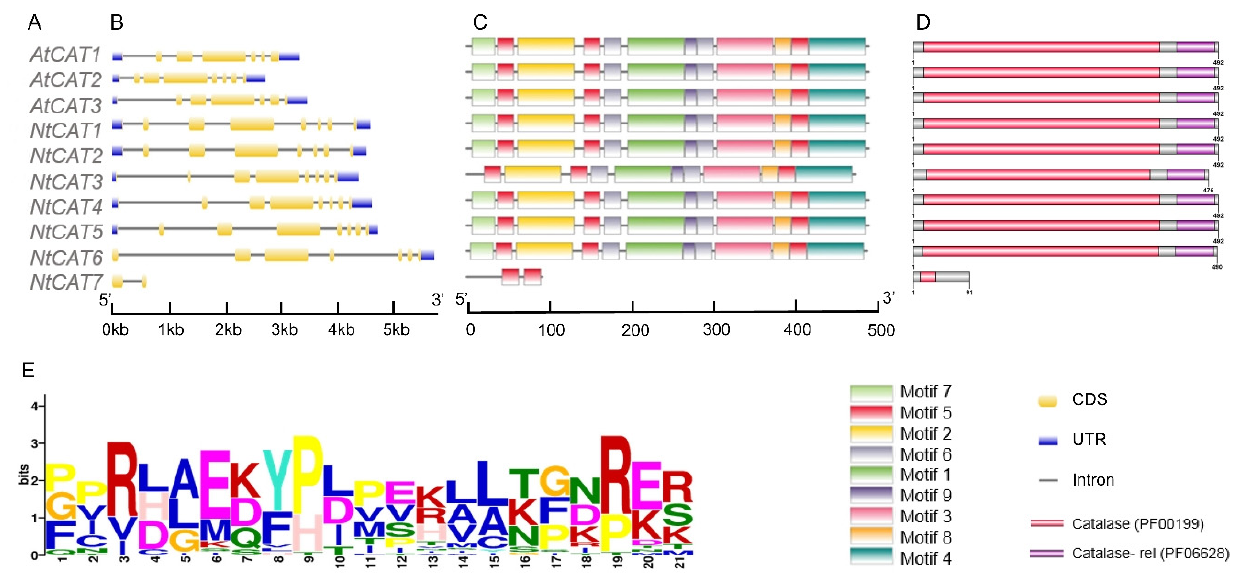
Figure 2. Analysis of evolutionary relationship, protein domains, multiple sequence alignment and gene structures of NtCATs . ( A ) Phylogenetic relationship in AtCATs and NtCATs . ( B ) The structure of NtCATs . The length of every region can be confirmed using the scale. ( C ) Nine conserved motifs of NtCATs were generated. Conserved motifs are shown in different-colored boxes. ( D ) The distribution of catalase core domain and catalase-related immune-responsive domain. ( E ) The sequences of Motif 5.